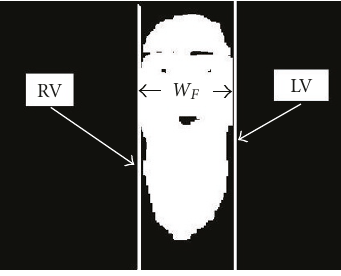
Figure 6: Skin tone cluster without